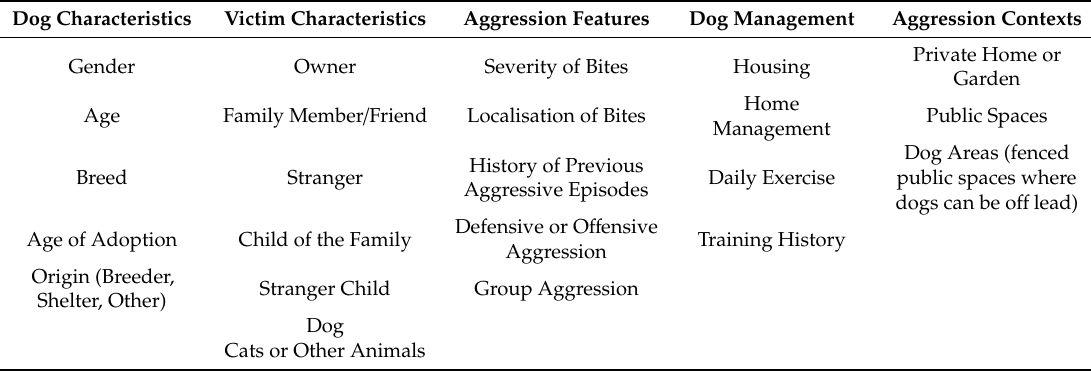
Table 1. Summary of the investigated areas.